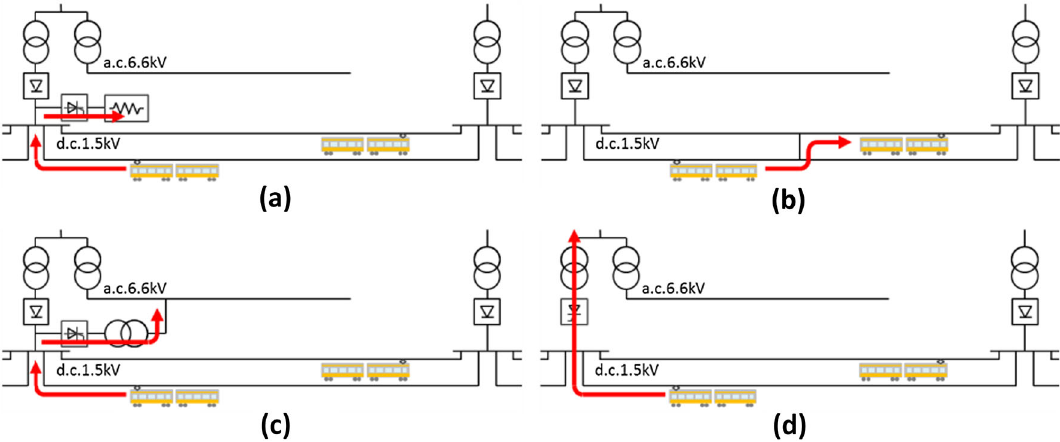
Fig. 6 Conventional solutions against residual regenerative energy. a Regenerative resistance, b tie feeding, c regenerative inverter, d PWM